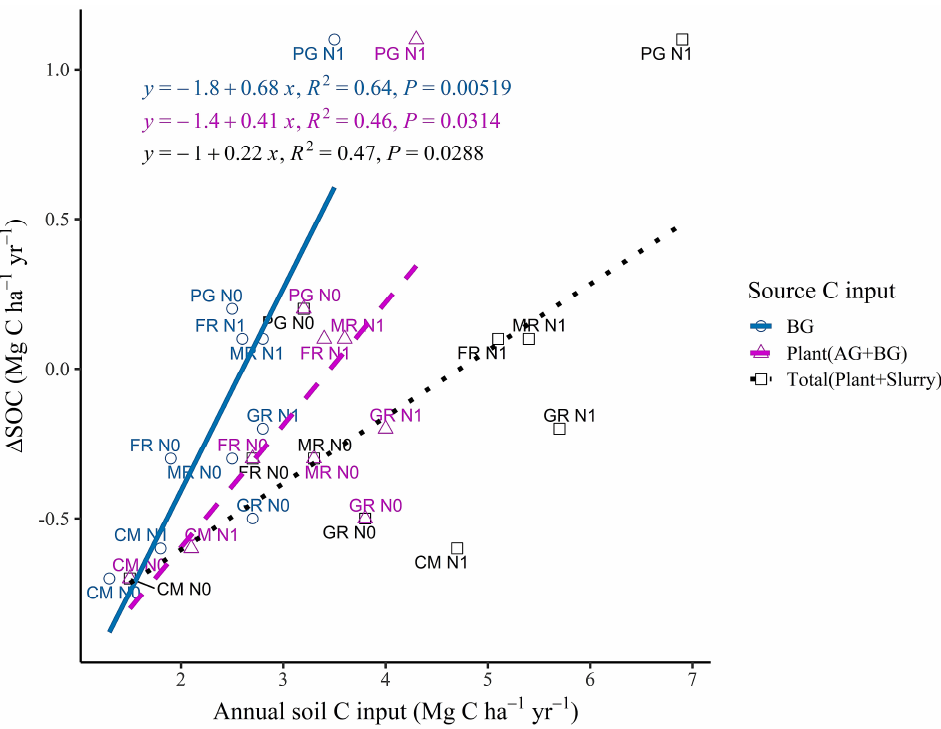
Figure 4. Relationship between annual soil C inputs from belowground (BG C in ), plant (AG C in + BG C in ), and total (Plant C in + Slurry C in ) with annual SOC changes ( ∆ SOC), for the different cropping systems (CS) and N rates in the topsoil layer (0–30 cm) in the period 2010–2018. CM: continuous silage maize, GR: grain rotation, FR: forage rotation, MR: mixed rotation, PG: per- manent grassland, N0: unfertilized, N1: fertilized using cattle slurry at a rate of 240 kg N ha − 1 in non-leguminous